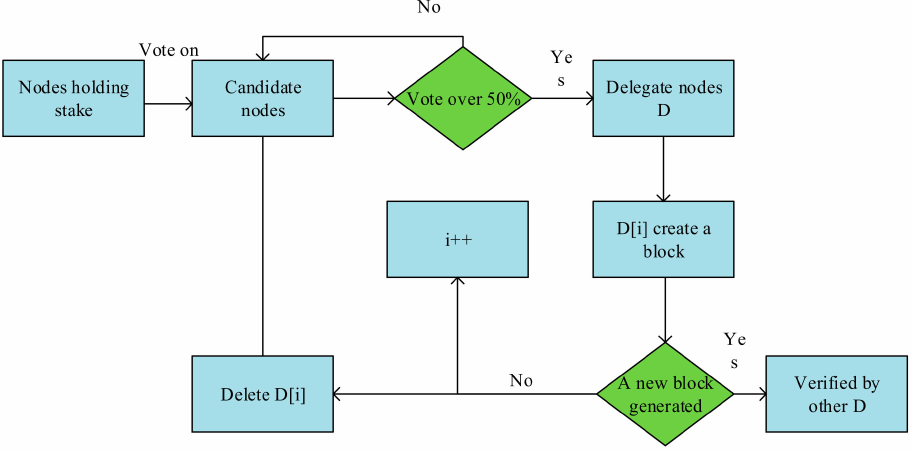
Figure 9. The working principle of the DPoS